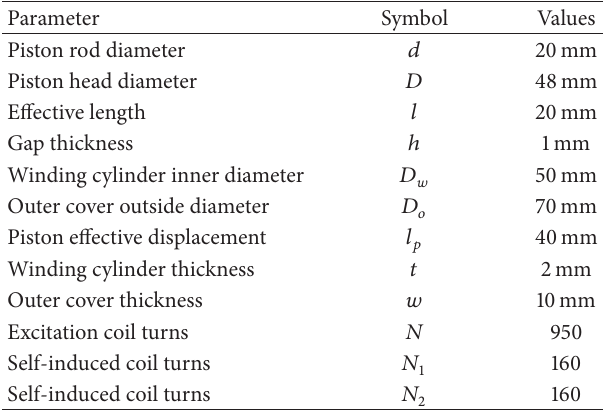
Table 1: Basic values of the structure parameters for the DDSMRD. Parameter Symbol